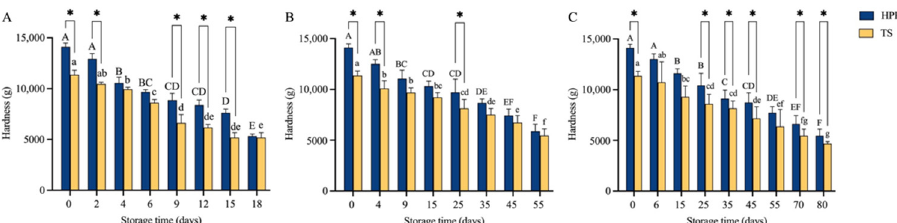
Figure 2. Changes in hardness of HPP and TS marinated lotus root slices during storage: ( A ) storage at 45 °C, ( B ) storage at 25 °C, ( C ) storage at 4 °C. Different letters indicate significant differences during storage ( p < 0.05) for the HPP (uppercase letters) and TS (lowercase letters) marinated lotus root slices. * p < 0.05. HPP, high-pressure processing; TS,